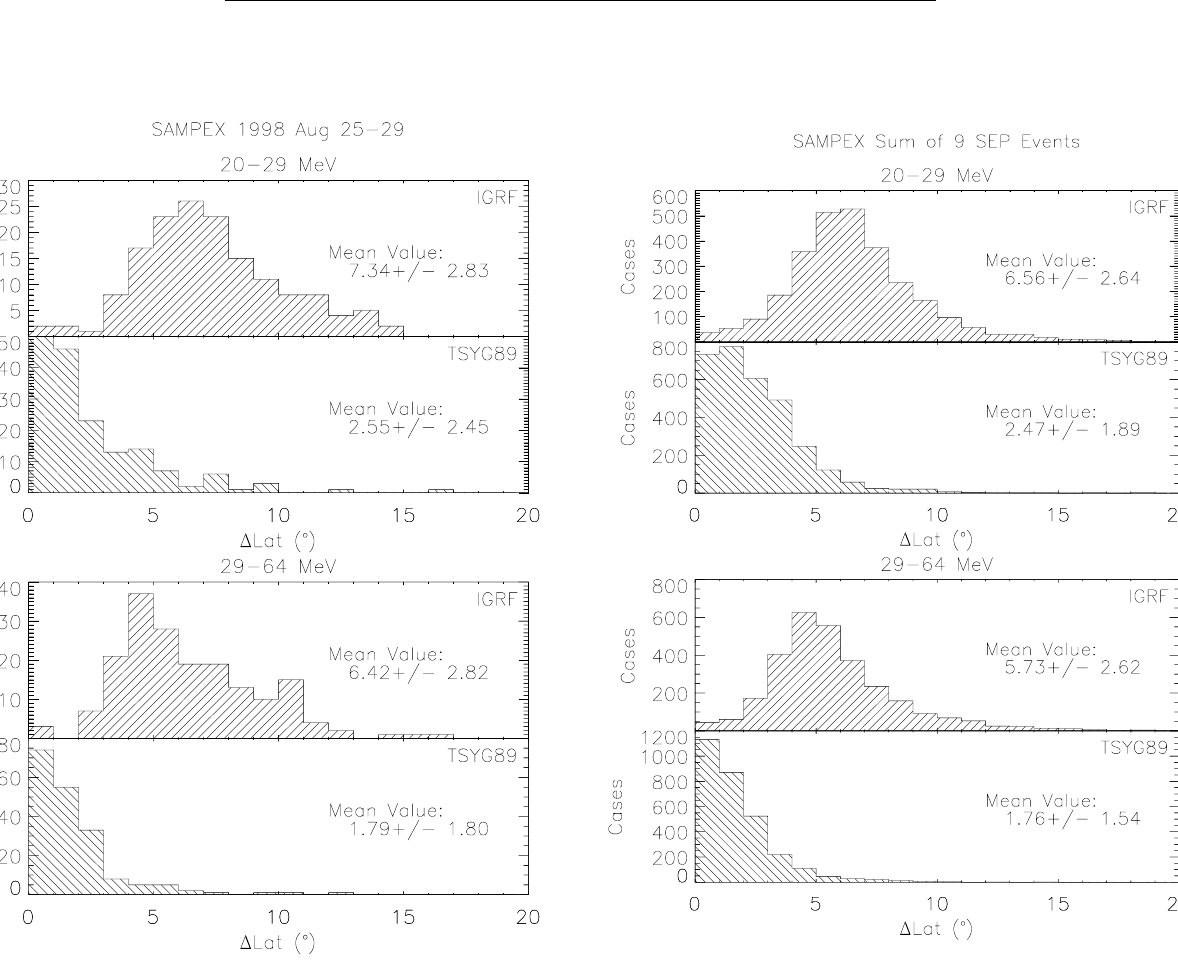
Fig. 3. Top panels: Histograms of numbers of cases for all nine SEP events of 1 Lat for the 20–29MeV protons with the IGRF model (top) and Tsyganenko model (bottom). Each case is a difference between the calculated (IGRF or Tsyganenko) and observed PET geographic cutoff latitudes. Bottom panel: Same as the above but for the 29–64MeV